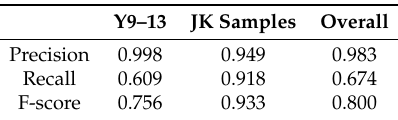
Table 7. Results of the evaluation of word segmentation in original texts by Chiri or Jinb¯o and Kanazawa against modern versions.